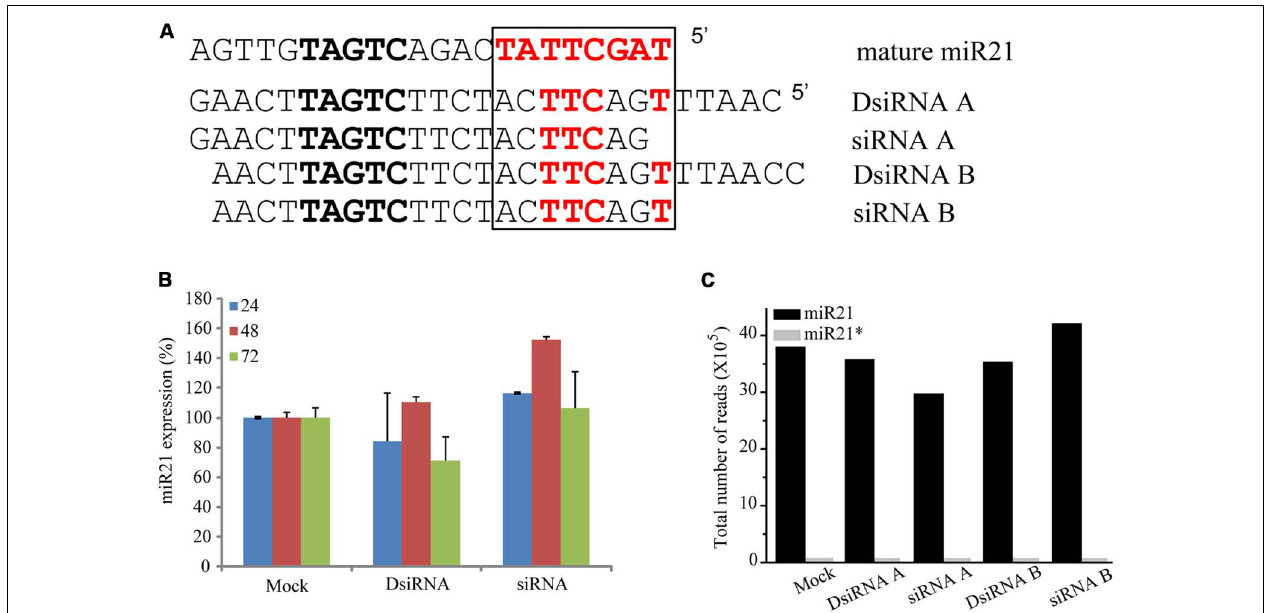
FIGURE 7 | siRNA did not controlled in miRNA. (A) Seed sequence (black box) of with mature miR21 and the evaluated small RNAs. (B) Abundance of miR21 in HCT116 cells transfected with DsiRNA B or siRNA B, as measured